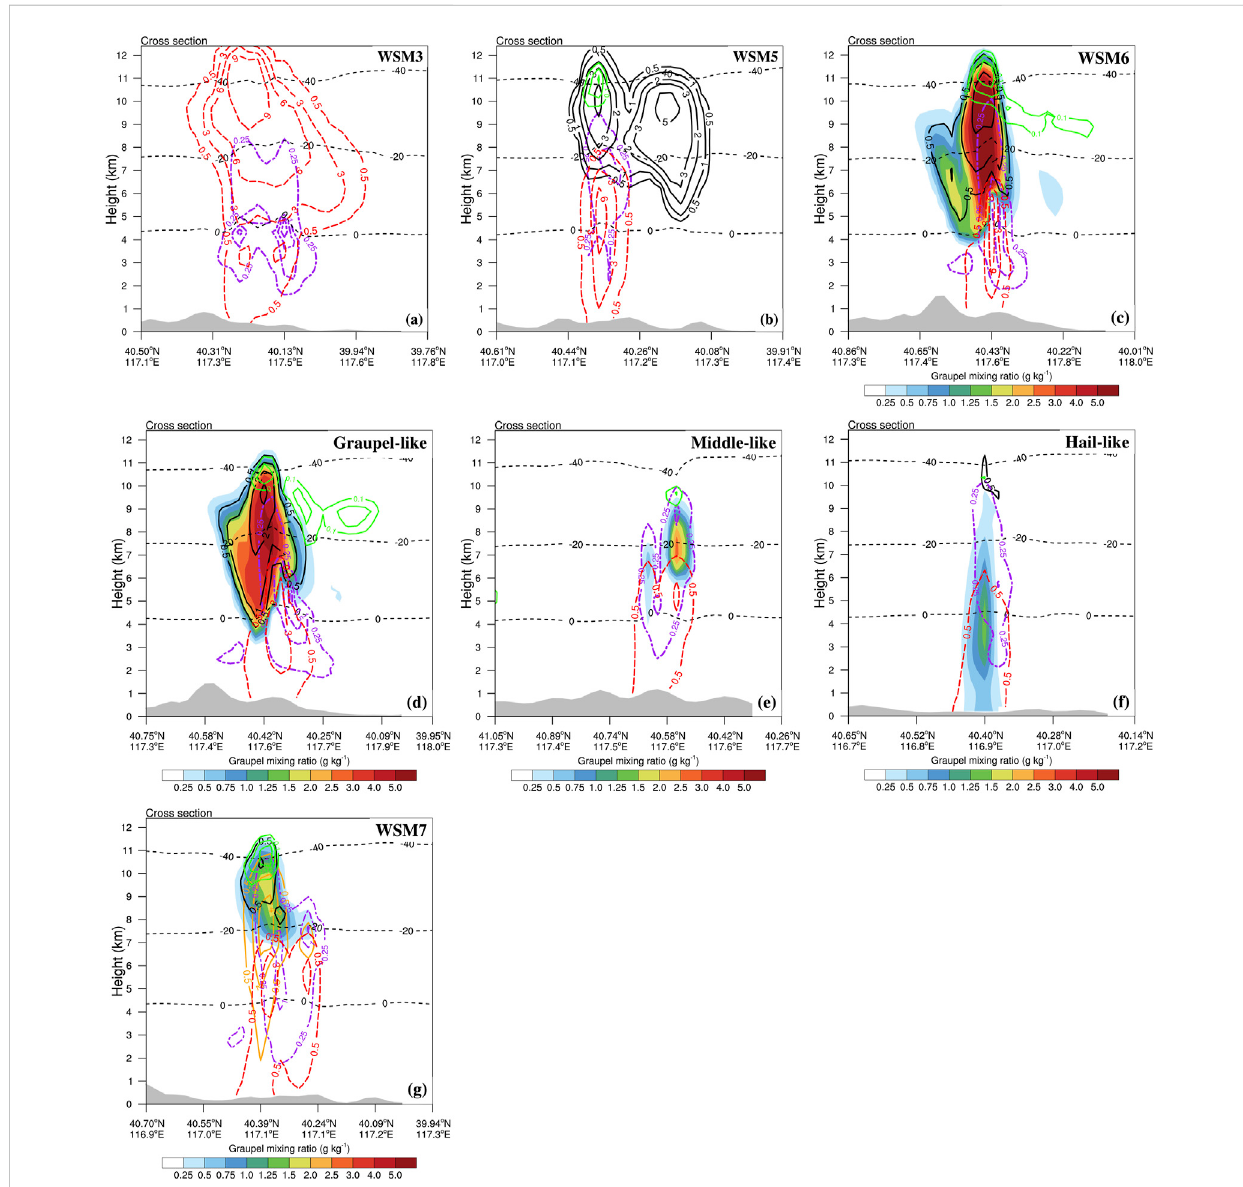
FIGURE 10 Vertical cross sections (along the black line in Figure 6) of the graupel (shaded; g kg − 1 ), cloud water (purple dot dashed lines; g kg − 1 ), rain water (red dashed lines; g kg − 1 ), cloud ice (green solid lines; g kg − 1 ), snow (black solid lines; g kg − 1 ) and hail (orange solid lines; g kg − 1 ) mixing ratios with the isotherm lines (black dashed lines; Isopleth interval is 20 ° C) at convective development stage for all experiments: (A) WSM3, (B) WSM5, (C) WSM6, (D) WSM6- Graupel-Like, (E) WSM6-Middle-Like, (F) WSM6-Hail-Like and (G) WSM7 experiments. The grey areas indicate the terrain